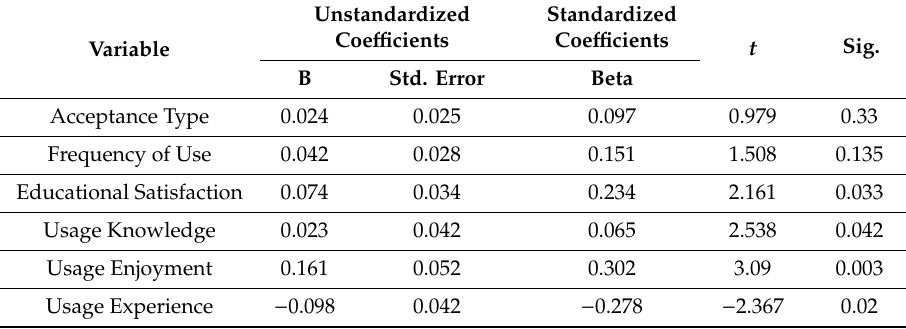
Table A1. Analysis result of external variables and ease of use (dependent variable: ease of use).